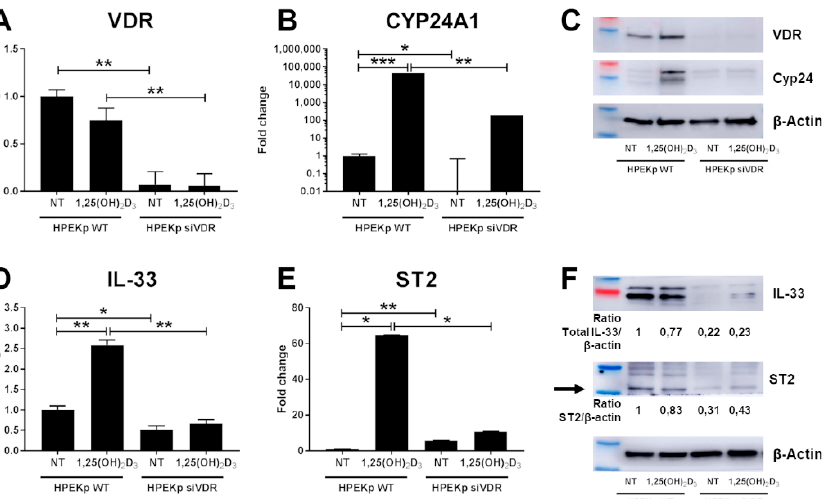
Figure 3. Knockdown of VDR in the human keratinocytes cell line (HPEKp) suppressed IL-33 and ST2 induction by 1,25(OH) 2 D 3 . ( A , B ) VDR ( A ), CYP24A1 ( B ), expression 72 h after siRNA tranfecton was measured by real-time PCR in HPEKp cell line. After positive siRNA transfection, IL-33 ( D ) and ST2 ( E ) mRNA expression was analysed with or without 1,25(OH) 2 D 3 (100 nM) stimulation. Immunoblotting for VDR, CYP24 ( C ), IL-33 and ST2 ( F ) was performed on lysate from HPEKp WT and siVDR cells with or without 1,25(OH) 2 D 3 treatment for 24 h. Blots were stripped and re-probed with anti- β -actin antibody to normalize for differences in protein loading. * p < 0.05, ** p < 0.01, *** p < 0.001.